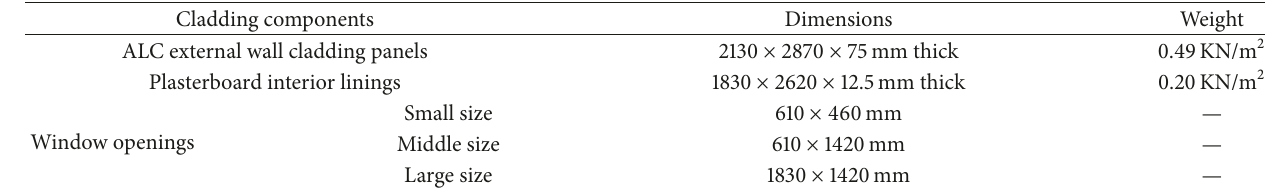
Table 1: Details of precast cladding